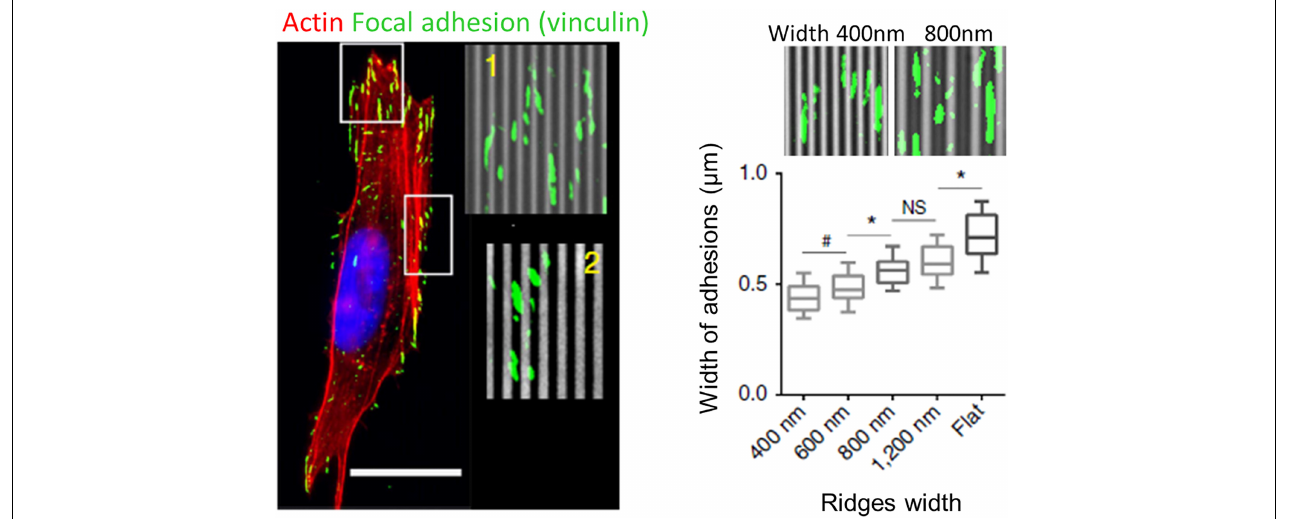
FIGURE 6 | Role of focal adhesions (FA) in topography sensing. Left: cancer cell aligned on a nanogrooved substrate stained for actin (red), vinculin (green), and nucleus (blue). Insets shows aligned FA (1) or non-aligned FA complexes (2). Scale 20 µ m. Right: Relationship between ridges width and FA width. From Ray et al. (2017). Symbols correspond to the p -values of the statistical tests performed: # P < 0.05, * P < 0.001, NS = no significance